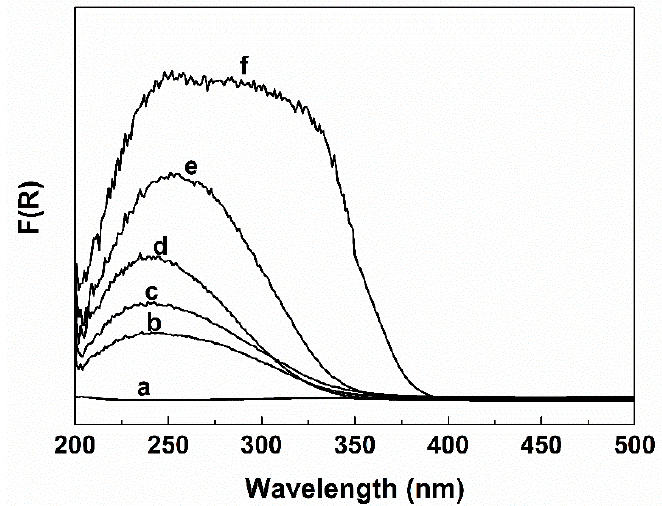
Figure 4. UV-vis spectra of calcined Ti-containing materials ( a ) HMS, ( b ) Ti-HMS(50), ( c ) Ti-HMS(30), ( d ) Ti-HMS(20), ( e ) Ti-HMS(10), and ( f ) anatase.